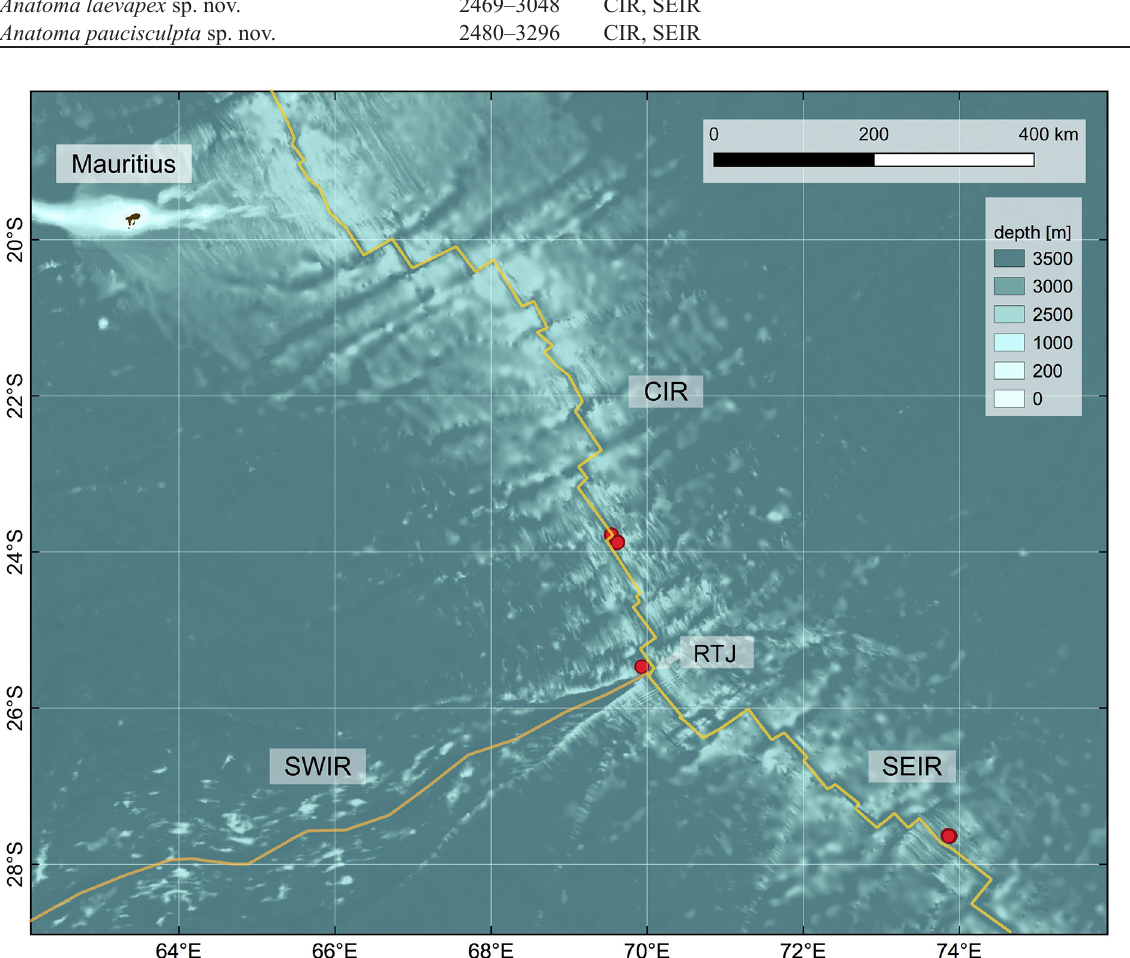
Fig. 1. Location map of oceanic plate ridges in the central Indian Ocean. Three areas are indicated by red dots where species in Anatoma Woodward, 1859 were encountered. Abbreviations: CIR = Central Indian Ridge; RTJ = Rodriguez Triple Junction; SEIR = SE Indian Ridge; SWIR = SW Indian Ridge. Map by QGIS using GEBCO bathymetry